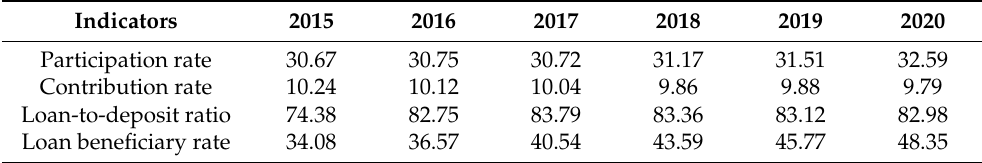
Table 2. The average of the HPF equity performance from 2015 to 2020 (%).